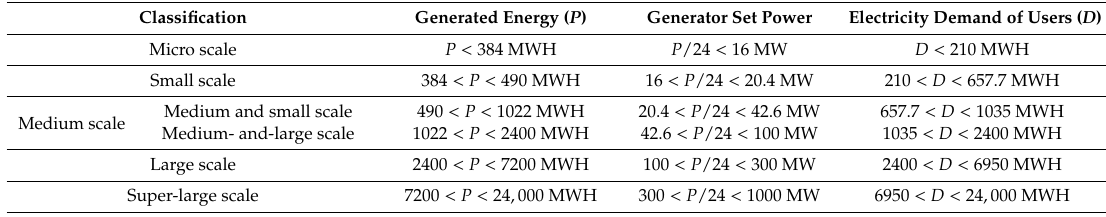
Table 7. Classification of the power plant scale and the power grid